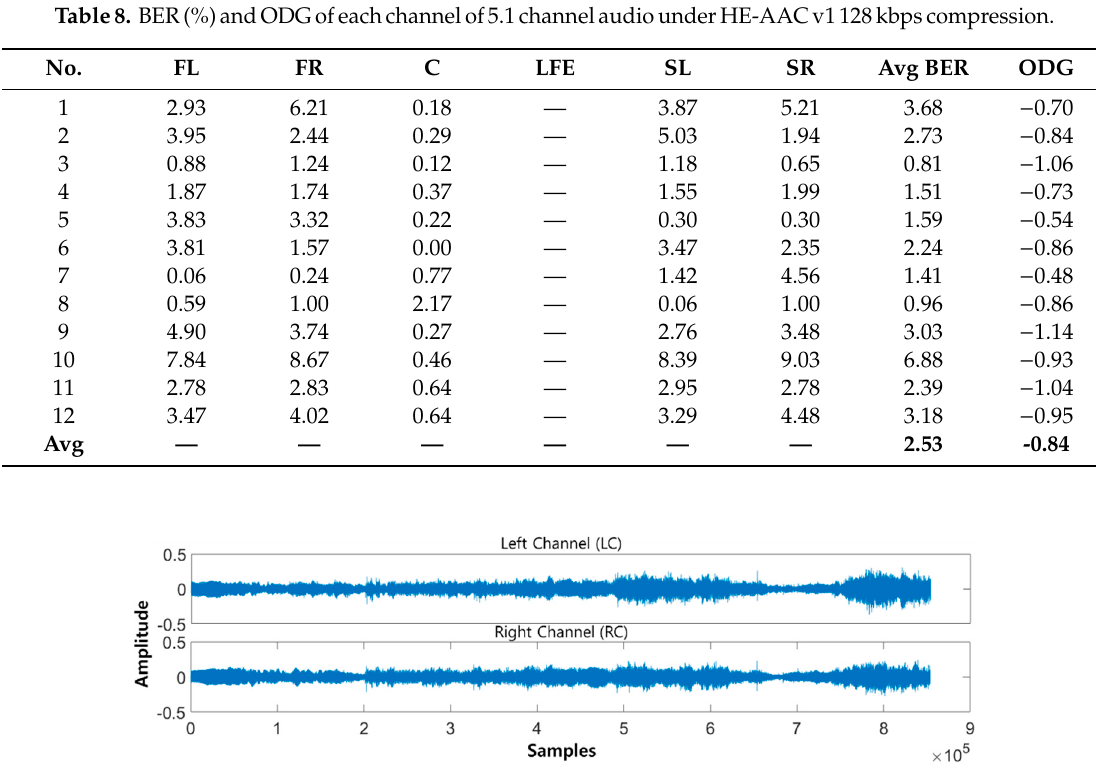
Figure 14. Time domain waveforms of the “Bach organ” stereo audio. Table 9. BER (%) and ODG of each channel of stereo audio under HE-AAC v2 48 kbps compression. Table 8. BER (%) and ODG of each channel of 5.1 channel audio under HE-AAC v1 128kbps compression.